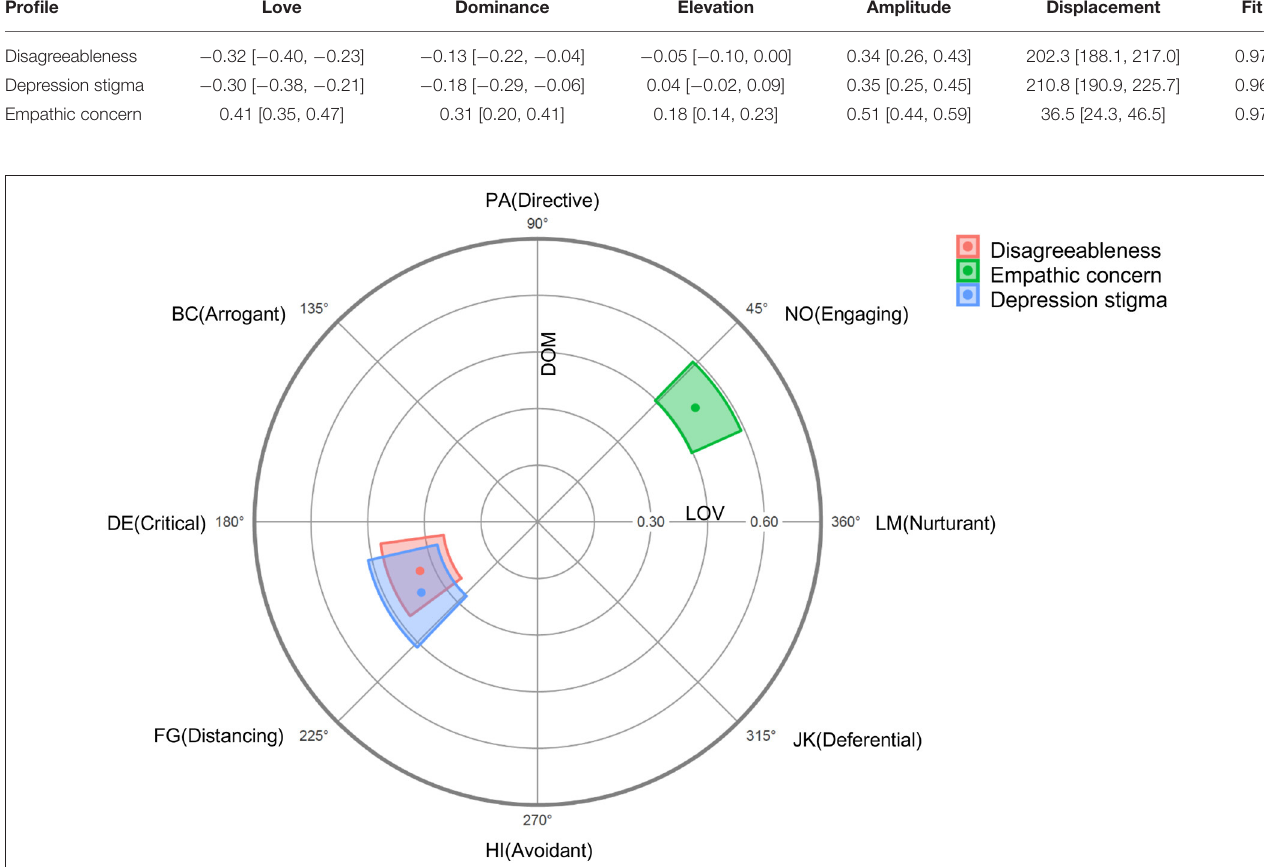
FIGURE 3 | Radar chart of Disagreeableness, Empathic concern and Depression stigma projected on to the SAS-C in Study 2. Dots represent mean values and coloured regions represent bootstrapped 95% confidence intervals (computed and plotted using the circumplex package for R; ( 67).